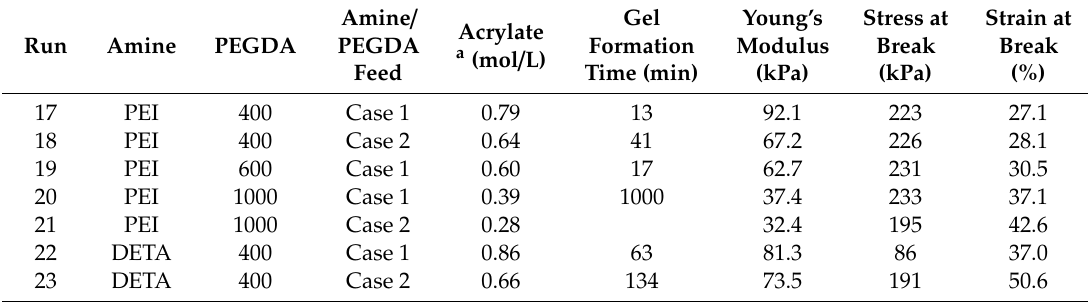
Table 3. Gel formation time and mechanical properties of PEI or DETA-PEGDA gels, solvent: EtOH, monomer concentration: 30 wt %.